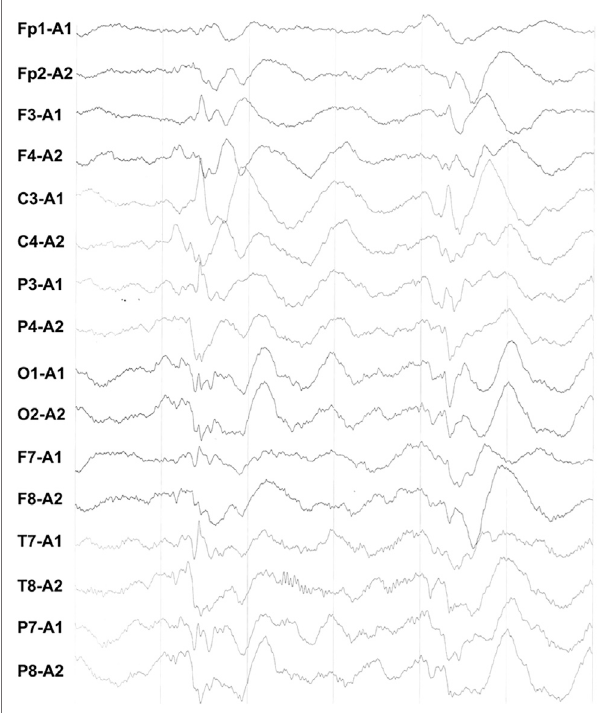
FIGURE 1 | During interictal EEG, diffuse irregular high amplitude slow waves of bilateral symmetry were found.